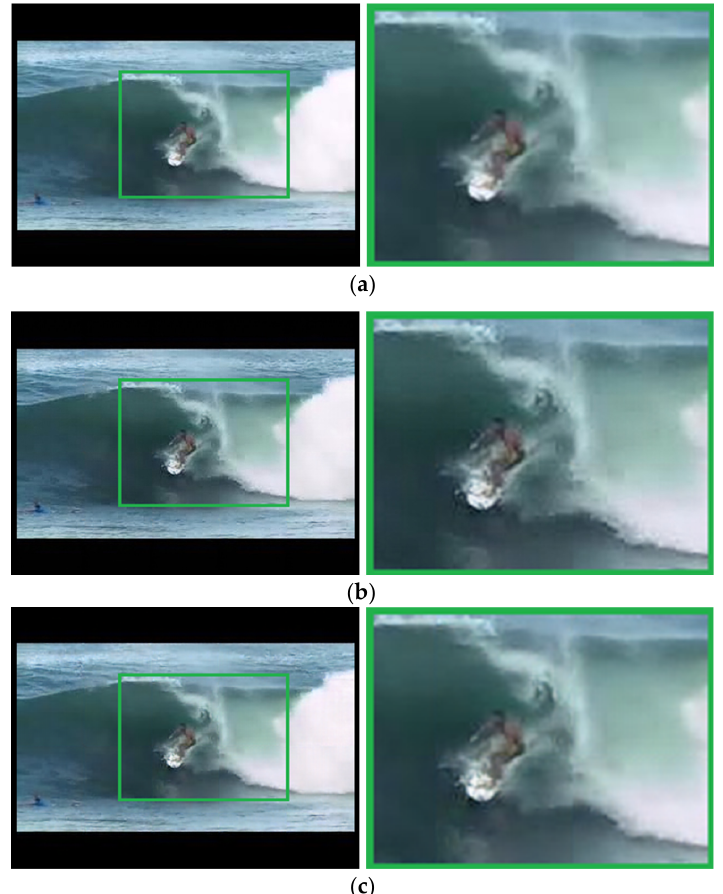
Figure 9. Comparison of SepConv and the proposed method on the generated output for the UCF101 dataset. The proposed framework keeps more structural details. Quality metrics for the generated output: ( a ) SepConv, PSNR = 30.35, SSIM = 0.796; ( b ) the proposed method (w/o refinement), PSNR = 29.66, SSIM = 0.839; ( c ) the proposed method (with refinement), PSNR = 30.71, SSIM = 0.807.